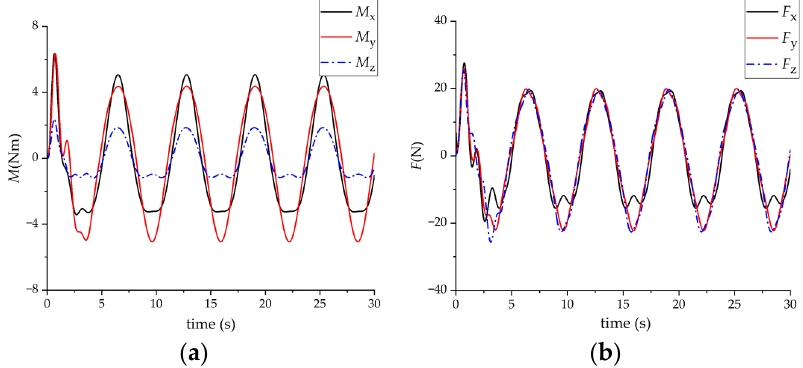
Figure 11. The output of the Virtual Force Sensor 1: ( a ) torque profiles and ( b ) force profiles. The above simulations are based on the assumption that the given positions of the two astronauts are the same; that is, the two astronauts have the same goal. In actual situations, the goals of the two astronauts are not necessarily the same, and they may even be in a state of mutual antagonism. Next, the simulation of two astronauts cooperatively carrying objects is carried out according to the following scenarios and conditions.